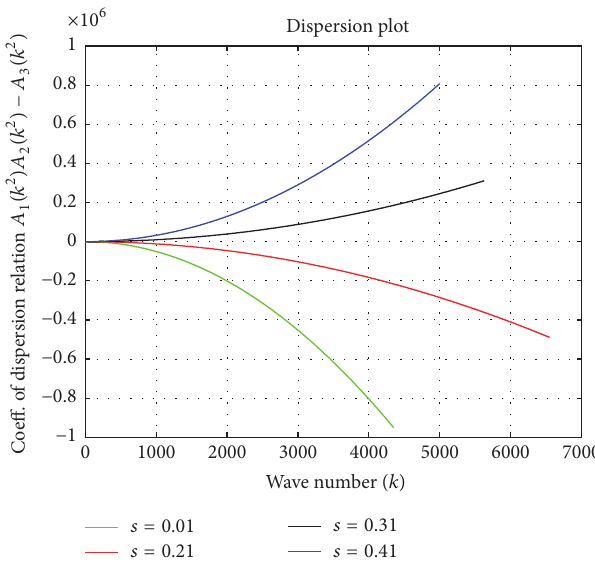
Figure 4: Here we plot the dispersion relation of the coefficient 𝐴 − 𝐴 𝐴 1 2 3 versus the wave numbers parameter 𝑠 .Recall thereisTuring instability when at least somepart of the coefficient 𝐴 1 𝐴 2 − 𝐴 3 lies below the 𝑘 axis.